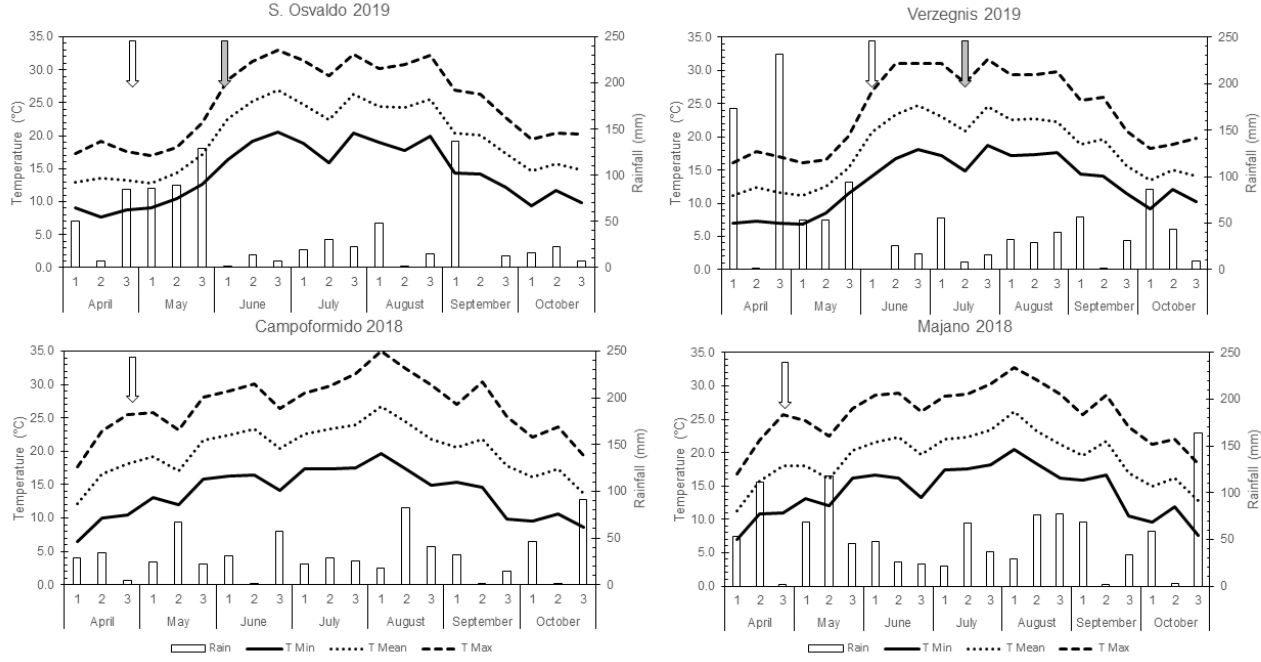
Figure 1. Daily mean temperature (T Mean), mean maximum temperature (T Max), minimum temperature (T Min), and total rainfall during the growing seasons (10-day values). White arrows represent conventional sowing time. Grey arrows represent delayed sowing time in SO2019D and VE2019D.